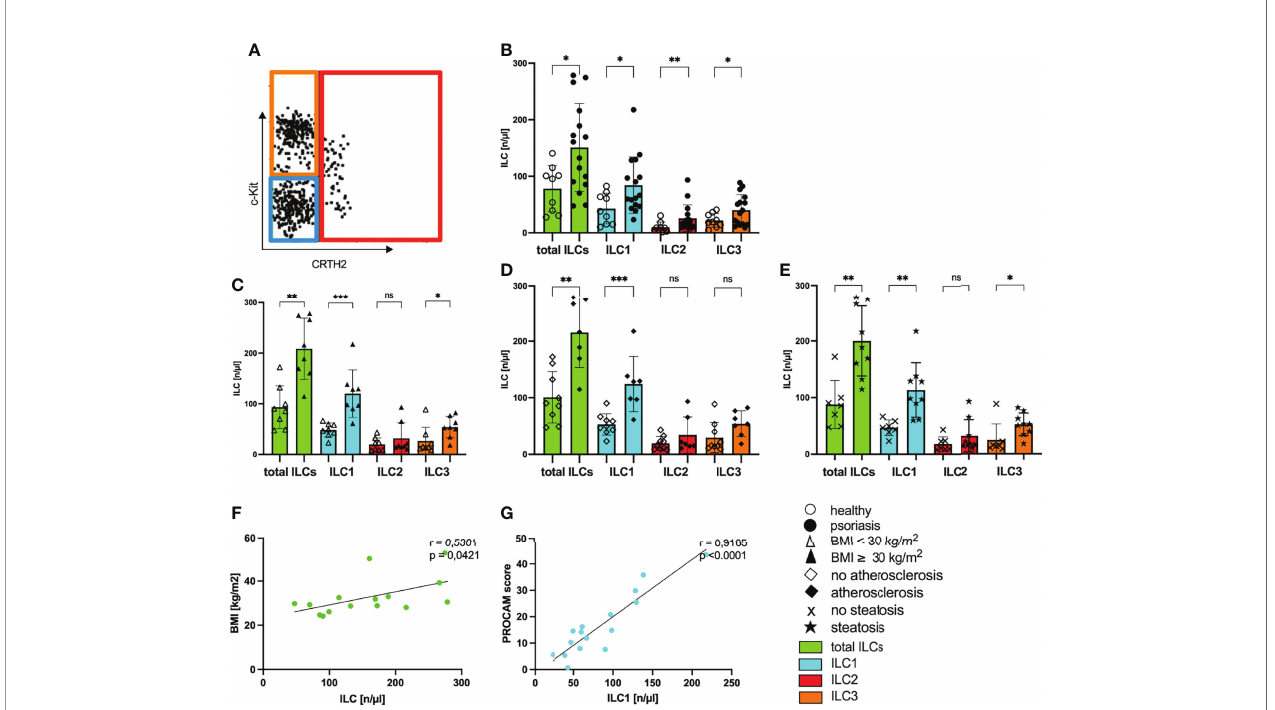
FIGURE 3 | Increased numbers of ILCs in blood of psoriatic patients with metabolic disorders. (A) Gating strategy to de fi ne subpopulations of innate lymphoid cells ILC1, ILC2, ILC3. Analysis was performed by fl ow cytometry by using lineage Cocktail-Paci fi c Blue (Biolegend), CD11c-BV421, CD34-BV421, CD94-BV421, FcERIa- BV421, CD45-VioGreen, CD117-PE (c-Kit), IL7RA-APC (CD127), CRTH2-APC-Cy7 (CD294). ILCs are pregated as CD45 positive cells that are further de fi ned by negative expression of the lineage cocktail and positive staining for IL7RA ( Supplementary Figure 2 ). The fi gure is presenting cells covering these criteria and their further subdivision by individual expression of surface antigens CD117 and CRTH2. ILC1 are blue bordered (CD117-, CRTH2-), ILC2 red (CRTH2+) and ILC3 orange (CD117+, CRTH2-). Total ILCs are colored in green. (B) Number of ILCs of healthy controls (un fi lled dots) and patients with psoriasis vulgaris ( fi lled dots) in blood, mean and SD, each dot represents an individual patient, Mann-Whitney test. (C) Number of ILCs in blood of normal-weight psoriatic patients (body mass index, BMI<30 kg/m 2 ; un fi lled triangle; n=8) and obese patients (BMI ≥ 30 kg/m 2 ; fi lled triangle; n=8) are shown, mean and SD, Mann-Whitney test. (D) Number of ILCs in blood of psoriatic patients without atherosclerosis (un fi lled trapezoid; n= 9) and with atherosclerosis ( fi lled trapezoid; n=7) are shown, mean and SD, Mann-Whitney test. (E) Number of ILCs of psoriatic patients without hepatic remodeling (cross symbol; n=7) and patients with steatosis hepatis (star; n=9), mean and SD, Mann- Whitney test. (F) Linear correlation of the number of circulating ILC and BMI (n=15), Pearson correlation. (G) Linear correlation of the number of circulating ILC1 and PROCAM score [%] (n=16), Pearson correlation. *p < 0.05; **p < 0.01; ***p < 0.001. ns, not signi fi